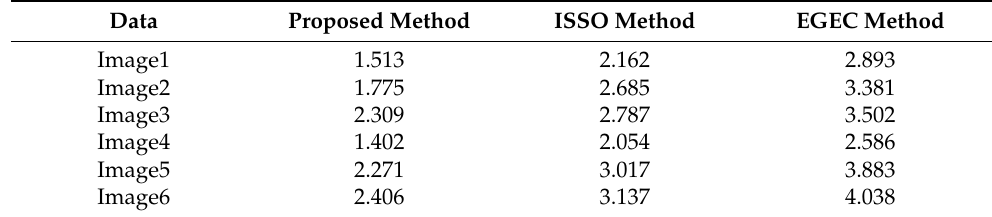
Table 4. The mean distance between feature point and intersection point of real images (pixel).